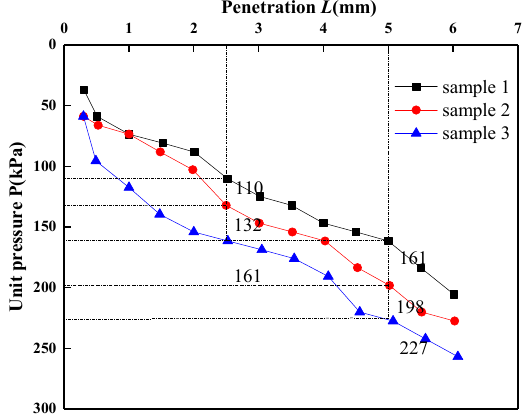
Figure 6. The relationship curve between unit pressure and penetration. Table 5. Calculation results of CBR value.